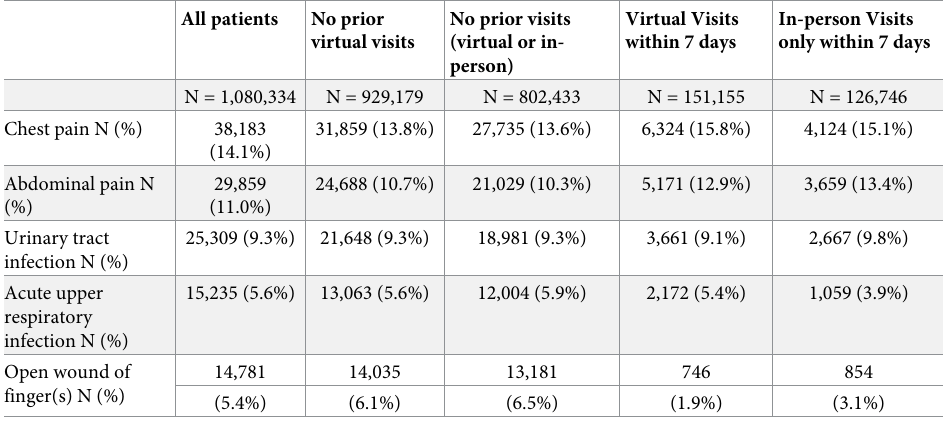
Table 3. Top 5 Reasons for ED admission, N (%), July 1, 2021- September 30, 2021. All patients No prior virtual